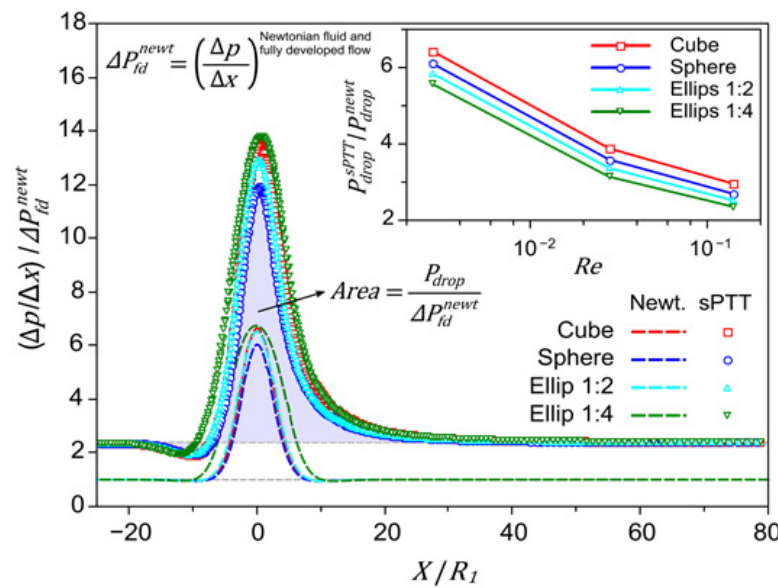
Figure 6. Normalized static pressure drop distribution along the x -direction for different prototypes (cube, sphere, ellipsoid 1:2 and ellipsoid 1:4) for Newtonian and viscoelastic fluid. Inset: increment of the pressure drop for a viscoelastic fluid with respect to the Newtonian case as a function of Re . Adapted from